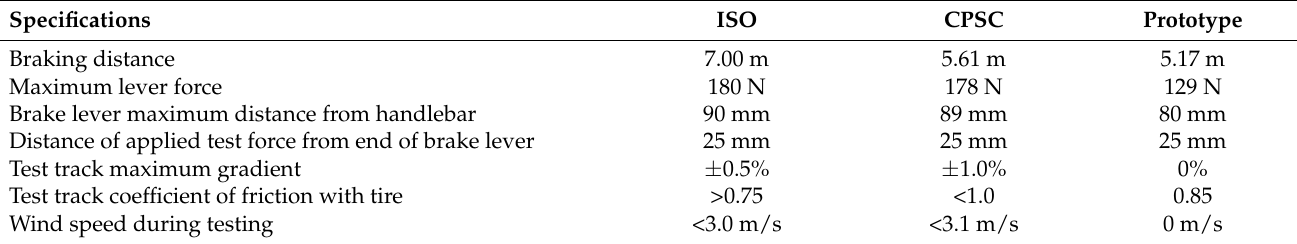
Table 6. Comparison of the CPSC and ISO test specifications against a simulation of the prototype system using the physical parameters of the e-bike detailed in Table 4.